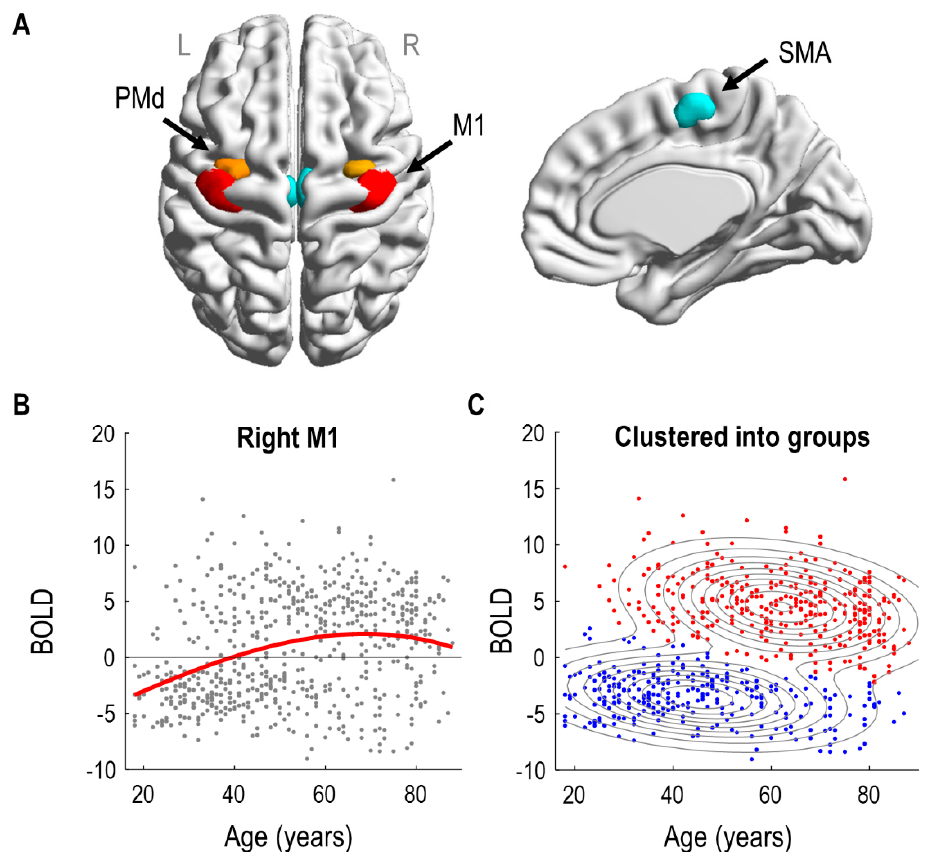
Figure 1. Regions of interest and the effect of age on right M1. ( A ) The six regions of interest are shown overlaid on a dorsal view of the cortical surface (left) and on a sagittal view of the right hemisphere (right). M1 = primary motor cortex (red), PMd = dorsal pre-motor cortex (orange), SMA = supplementary motor area (turquoise). ( B ) Confound-corrected relationship between age and the estimated neural response to Auditory + Visual trials in rM1, from an initial mass-univariate (SPM) analysis. The red line is the best fit of a third order polynomial, matching the SPM analysis used to identify rM1. ( C ) The same rM1 responses with assignments to two clusters using a Gaussian mixture model. Contours indicate the two Gaussians with colours of the individual subjects (dots) indicating cluster assignment. The younger group (with mainly negative BOLD) were described by a 2D-Gaussian with means [44.77 − 3.53] for age and BOLD response, respectively, with variances [289.71 5.20] and covariance − 11.16. The older group (with mainly positive BOLD) were described by a 2D-Gaussian with means [62.07 4.51], with variances [238.31 8.12] and covariance − 12.43. Ren- derings were performed using BrainNet Viewer (http://www.nitrc.org/projects/bnv/ (accessed on 23 June 2021))